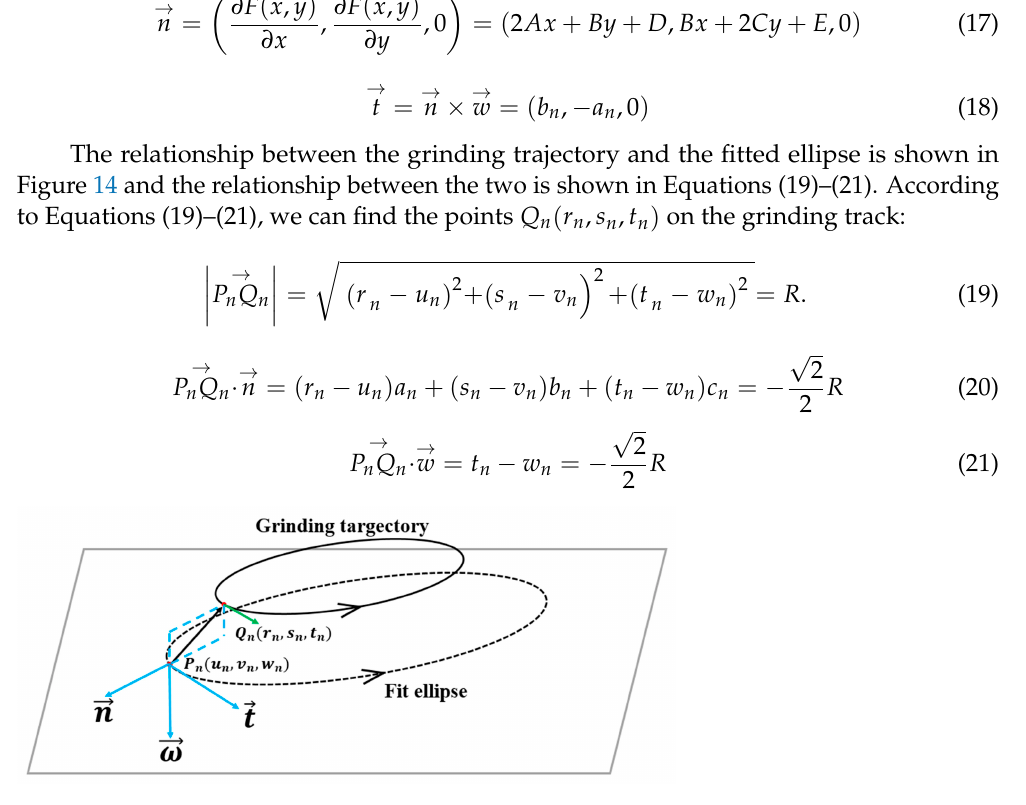
Figure 14. The relationship between grinding track and fitting ellipse.